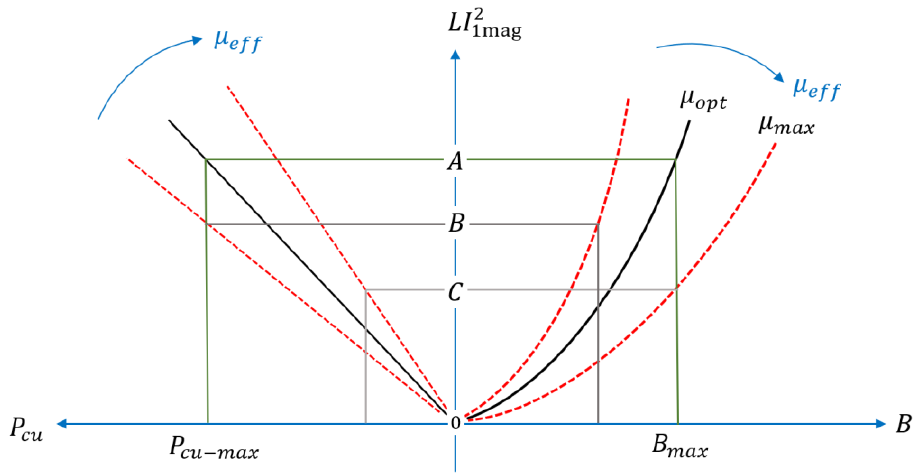
Figure 1. Optimal effective permeability.